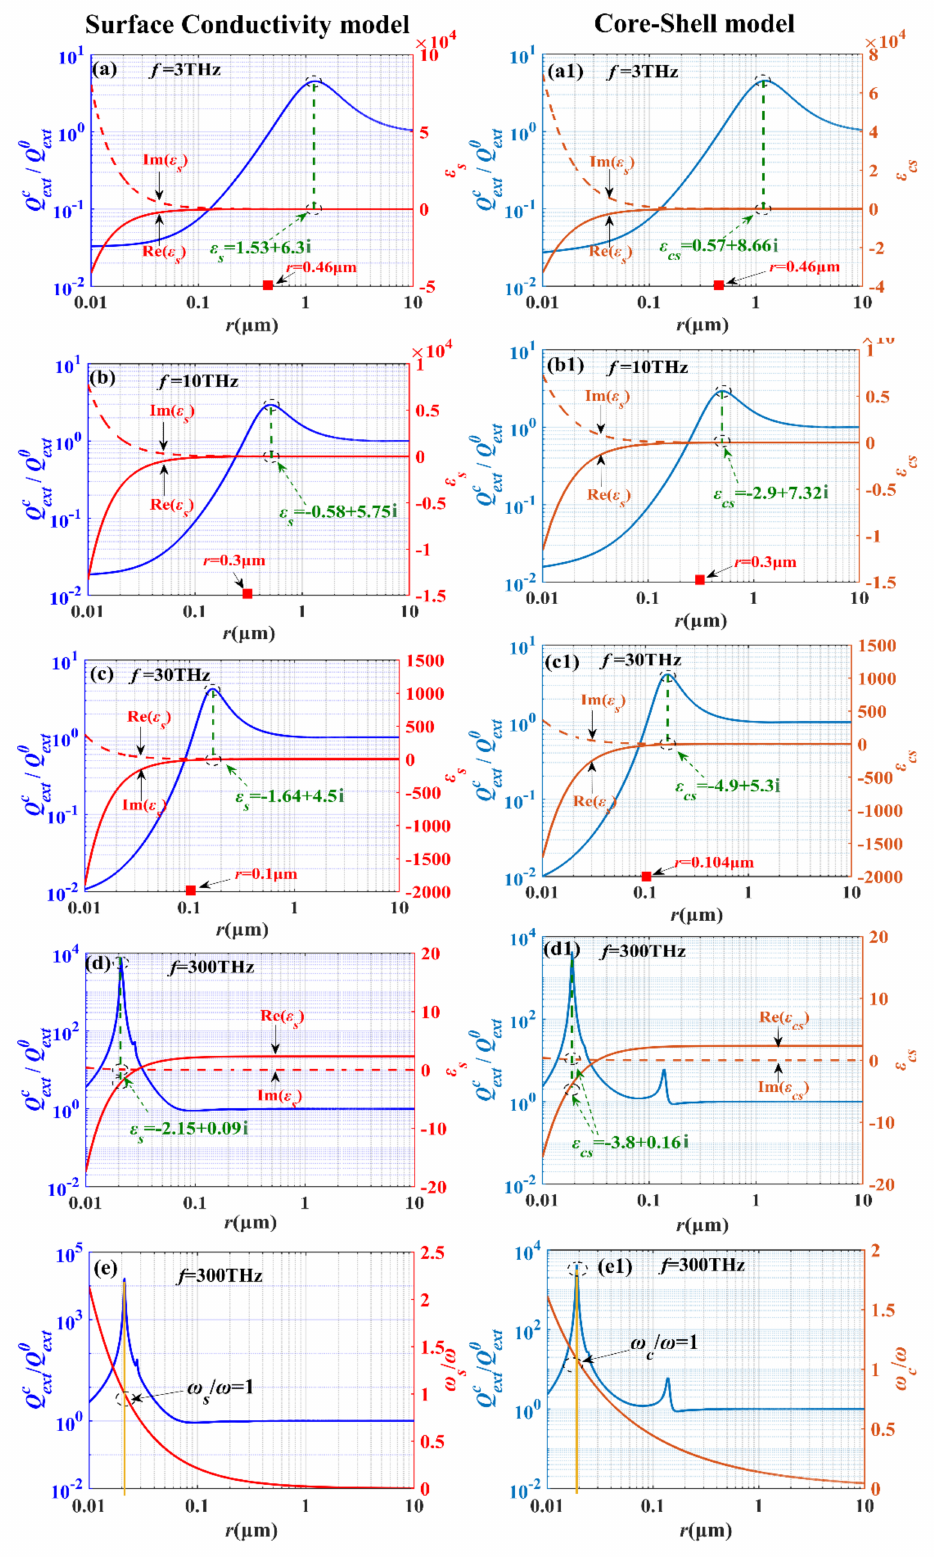
Figure 5. Extinction amplification factors Q c / Q 0 and equivalent dielectric functions (i.e., ε s and ext ext ε cs ), which are given by the surface conductivity model ( a – d ) and the Core-shell model ( a1 – d1 ), respectively, for frequencies f = 3 THz, 10 THz, 30 THz and 300 THz. ( e , e1 ) shows the normalized excitation frequencies (i.e., ω s / ω and ω c / ω ) for f = 300 THz given by the two models, respectively. Here, for each fixed r , it is assumed that the particle’s net charge gets saturated, namely by q = q max ( r